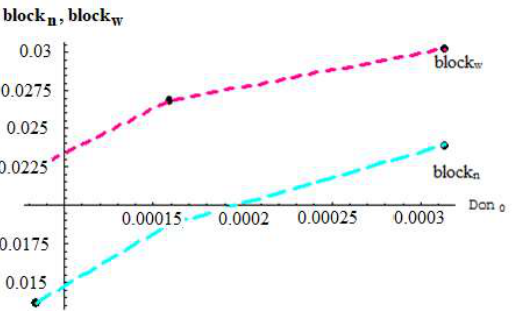
Figure 8. Dependence on the initial electron donor concentration of the molar block n and mass (or weight) block w fractions of stereoblock chains synthesized at the residence time in the reactor τ = 60 min.